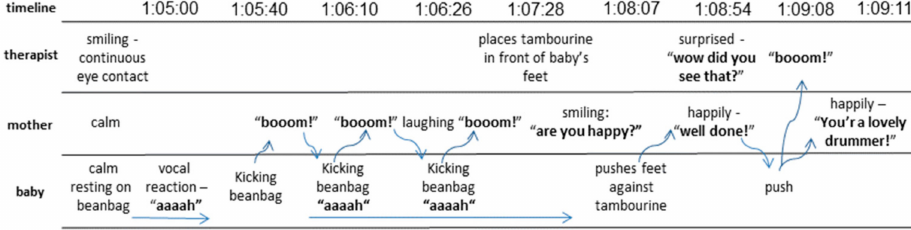
Figure 3. An illustration of a music and movement